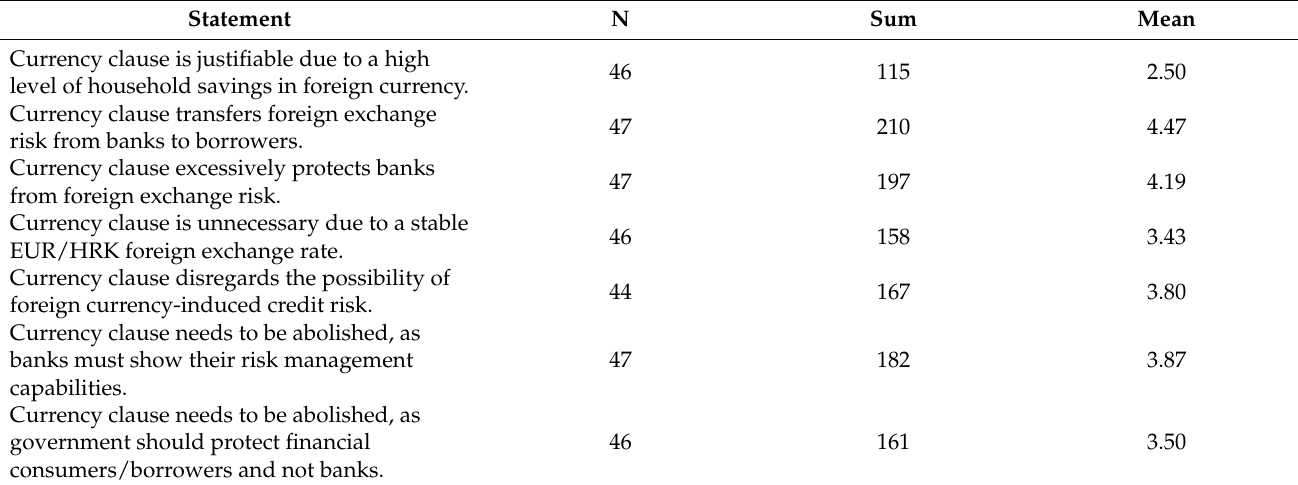
Table 9. Descriptive statistics of points assigned to statements about FX clause.